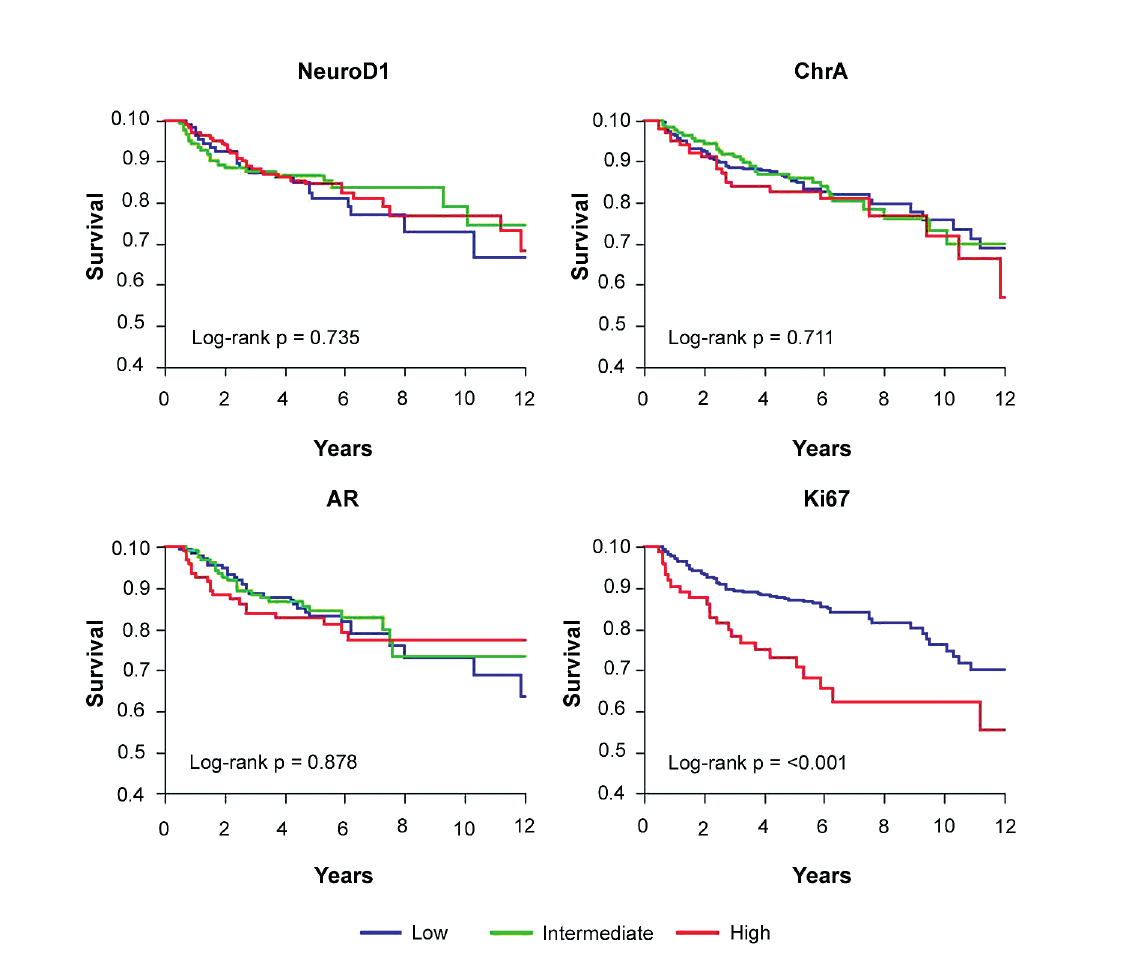
Figure 1 – Progression free survival according to the markers tissue reactivity. ChrA = chromogranin-A; AR = androgen receptor; Ki67 = Ki67 label index. In the first panel, the blue line is referred to the group without NeuroD1 tissue reactivity indicated as